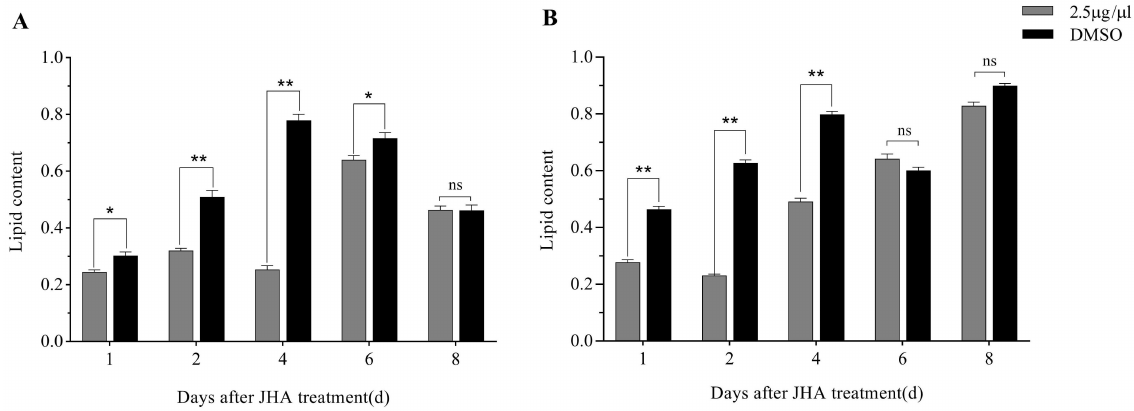
Figure 2. Effects of JHA on the total lipid content of G. daurica adults. ( A ) JHA application 3 days after adult eclosion. ( B ) JHA application 5 days after adult eclosion. The data are shown as the mean ± SE. * and ** indicate significant difference at p < 0.05 and p < 0.01, respectively, and ‘ns’ means no significant difference at p < 0.05 (Student’s t